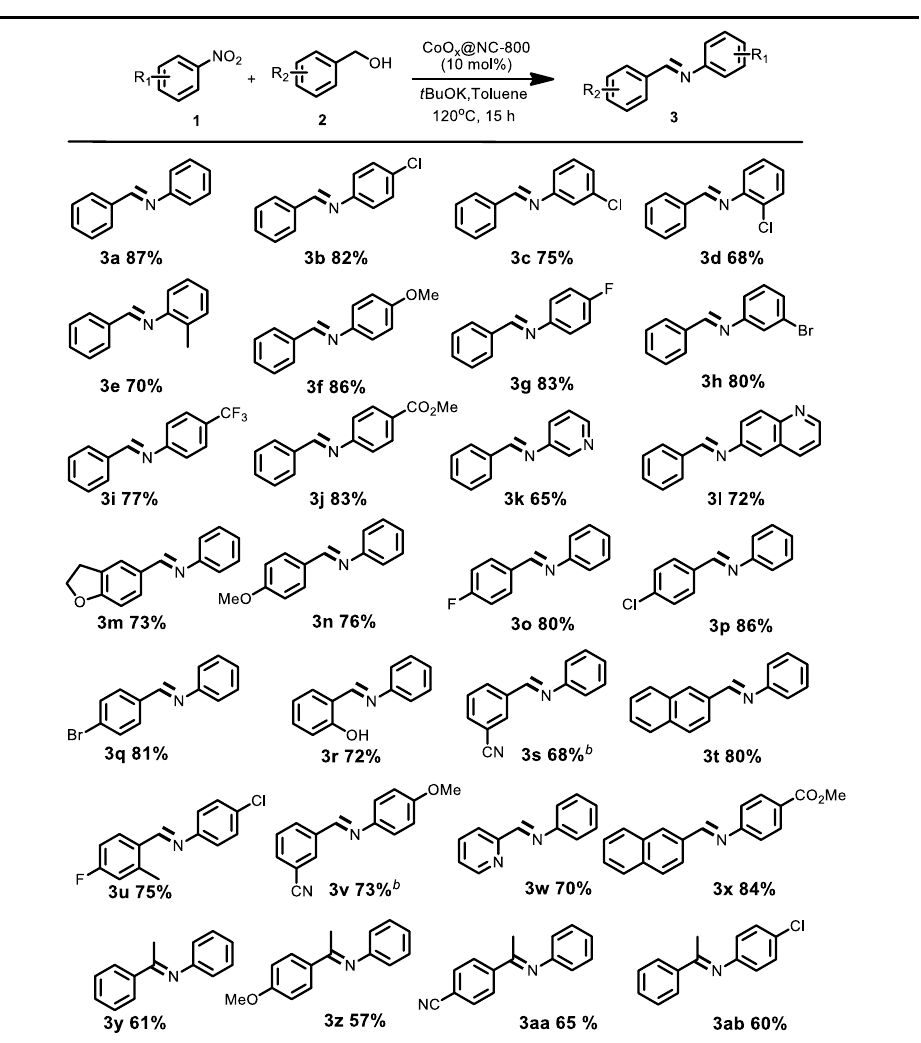
Table 2. Synthesis of imines from various alcohols and nitroarenes a .